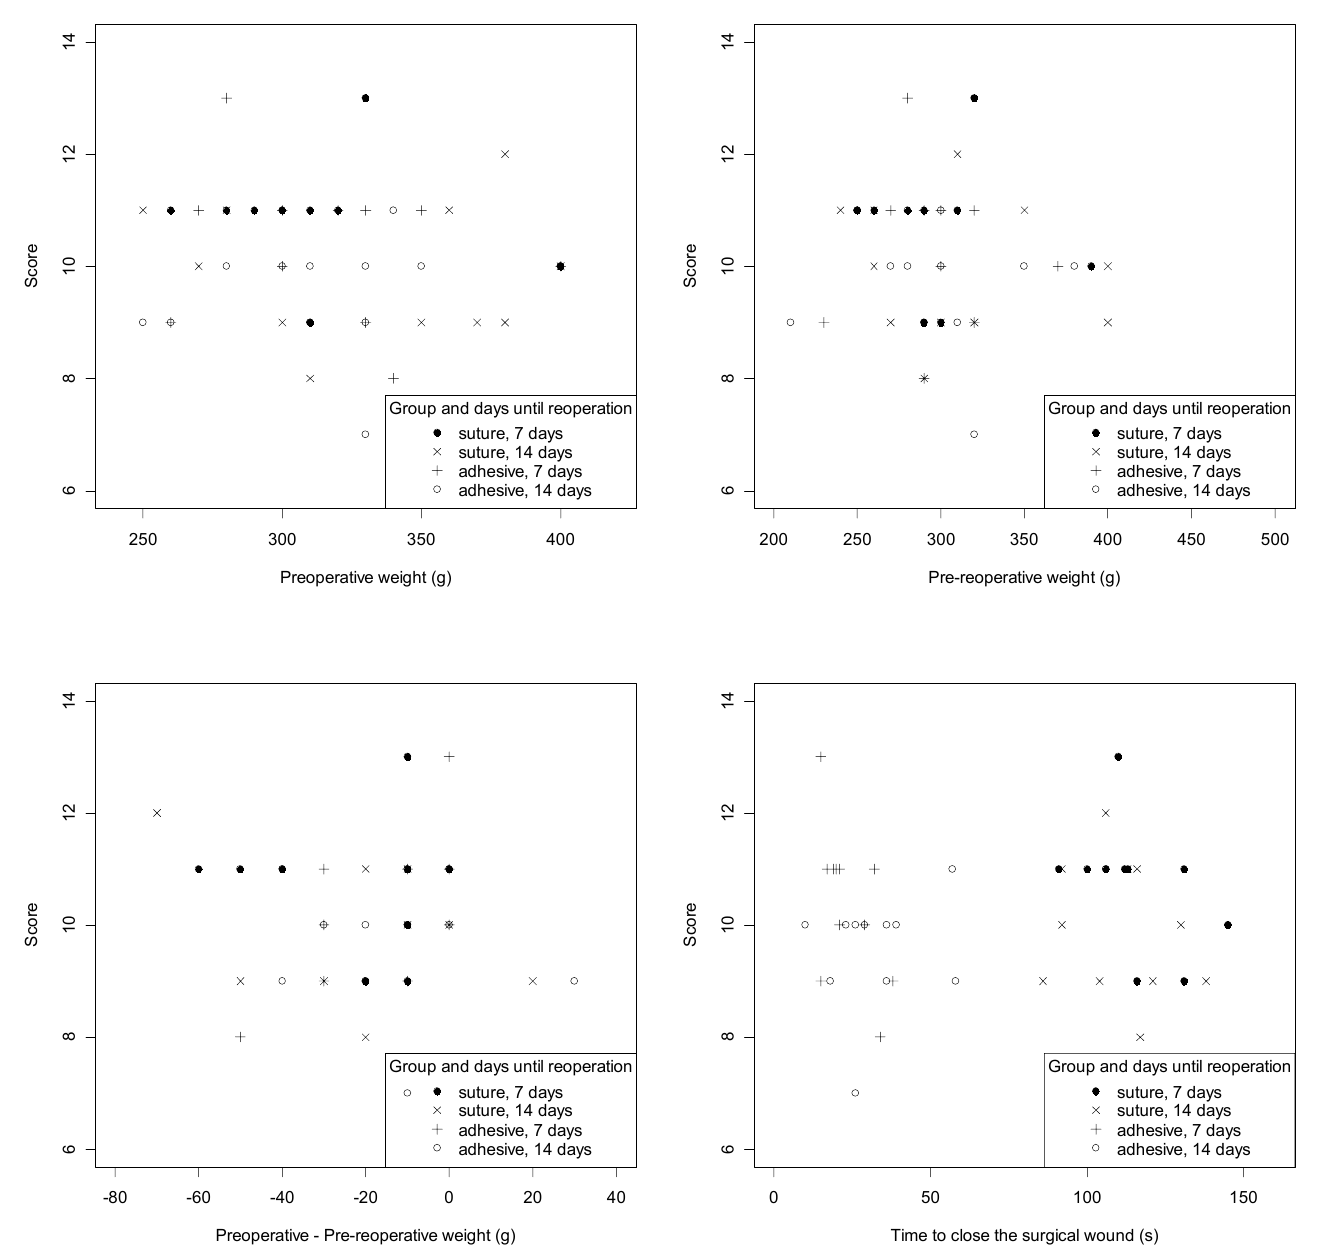
FIGURE 6 – Graphs showing the dispersion between tensile strength and the following variables: preoperative weight, pre-reoperative weight, weight difference, and time to close the surgical wound